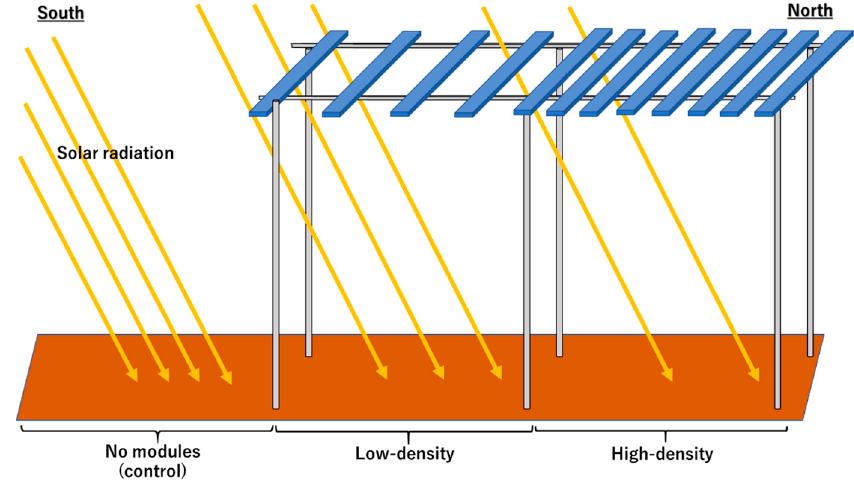
Figure 2. PV module configurations at the agrivoltaic experimental farm.